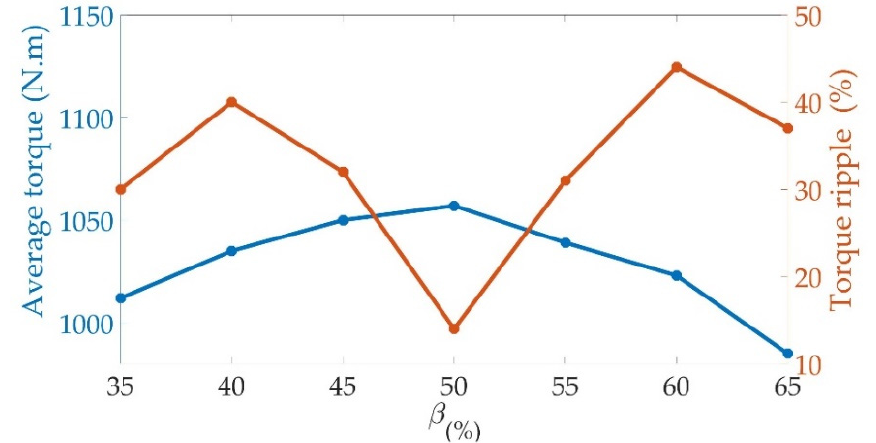
Figure 15. Average torque and torque ripple for different ratios β ( α = 0%).